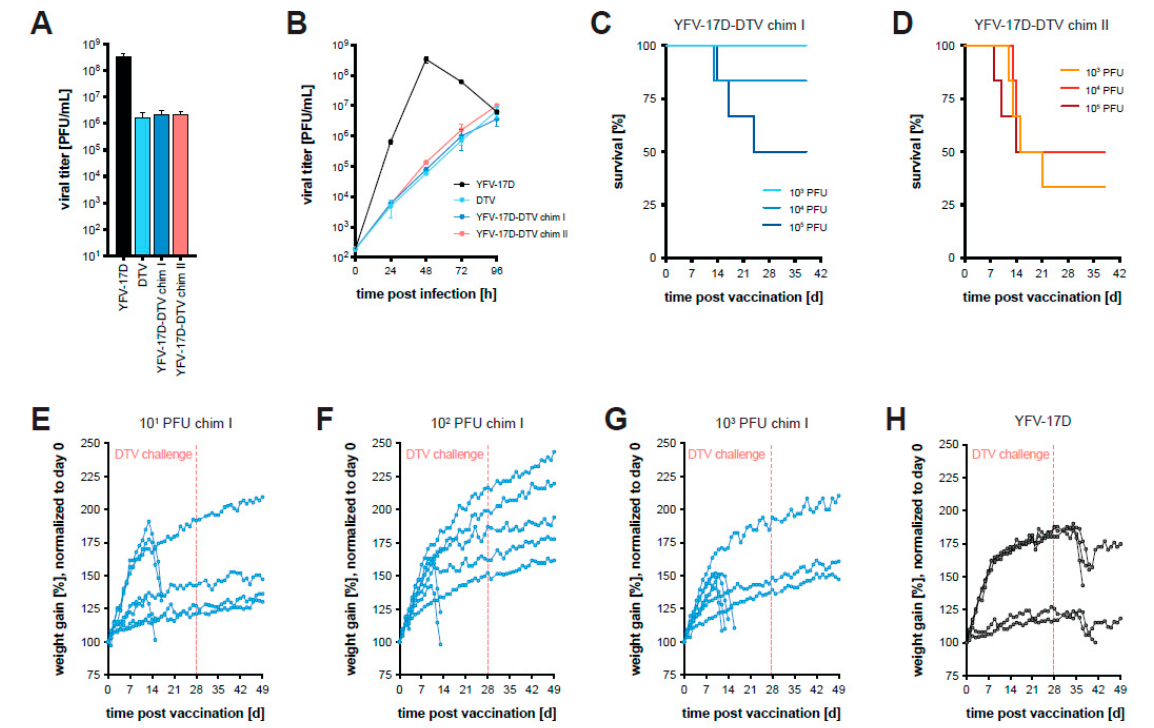
Figure 3. Replication kinetics of chimeric and parental viruses in vitro and in vivo. ( A , B ) Huh- 7.5 cells were infected with the parental YFV-17D and DTV, and the chimeric viruses I and II at ( A ) MOI = 1 PFU/cell and ( B ) MOI = 0.005 PFU/cell. Supernatants were harvested at the indicated time points and the infectious virus was titered by plaque assay. Mean titers of triplicate samples are plotted; error bars indicate the SD. ( C , D ) Survival curves of BL6 mice inoculated i.p. with the indicated doses of Chimera I and II ( n = 6 per cohort). ( E – G ) Normalized weights of BL6 mice vaccinated s.c. with the indicated doses of Chimera I ( n = 7 per cohort) and challenged with a lethal dose of WT DTV at 28 days post-vaccination. ( H ) Control cohort for ( E – G ) where mice were “vaccinated” with 10 3 PFU of the parental YFV-17D ( n = 5). To potentially limit the virulence observed during infection by Chimera I virus, four- week-old BL6 mice ( n = 7) were inoculated with lower doses (10 1 , 10 2 , 10 3 PFU) via